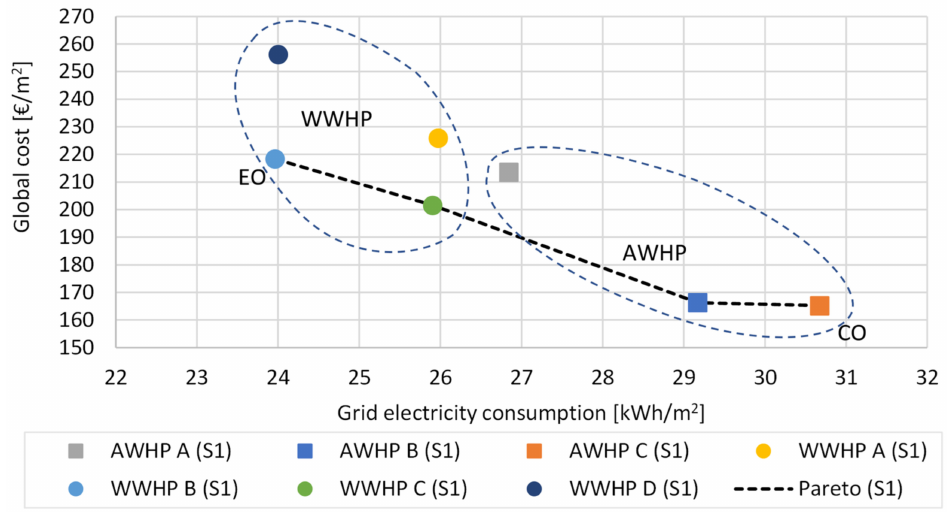
Figure 10. Results of global cost and grid electricity consumption from simulations for AWHP and WWHP systems with PV collectors covering nonrenewable part of electricity for the case with neglected PLF (scenario 1).